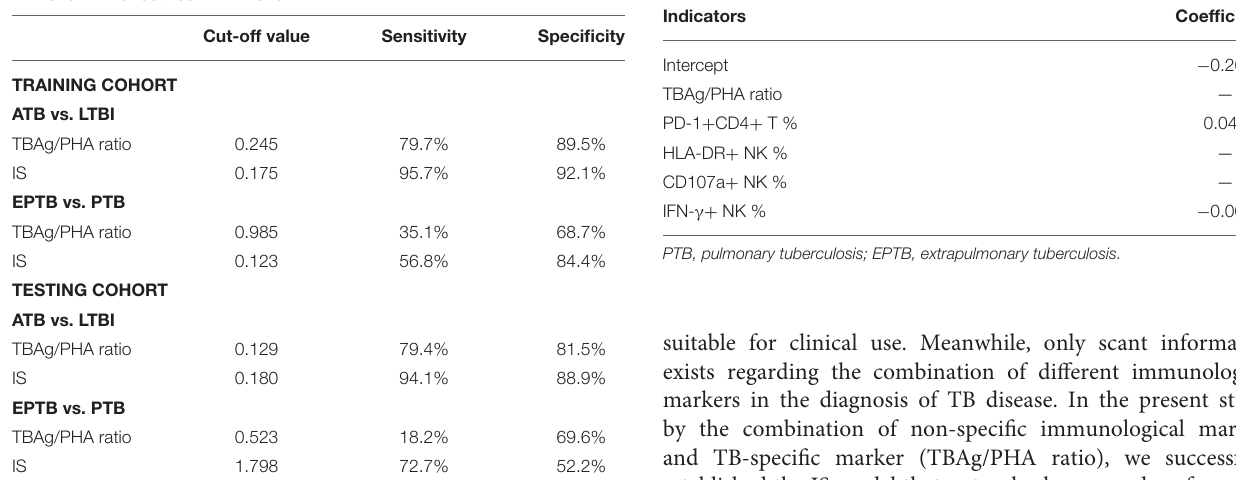
TABLE 2 | Performance of the TBAg/PHA ratio and IS for discriminating between ATB and LTBI or between EPTB and PTB.